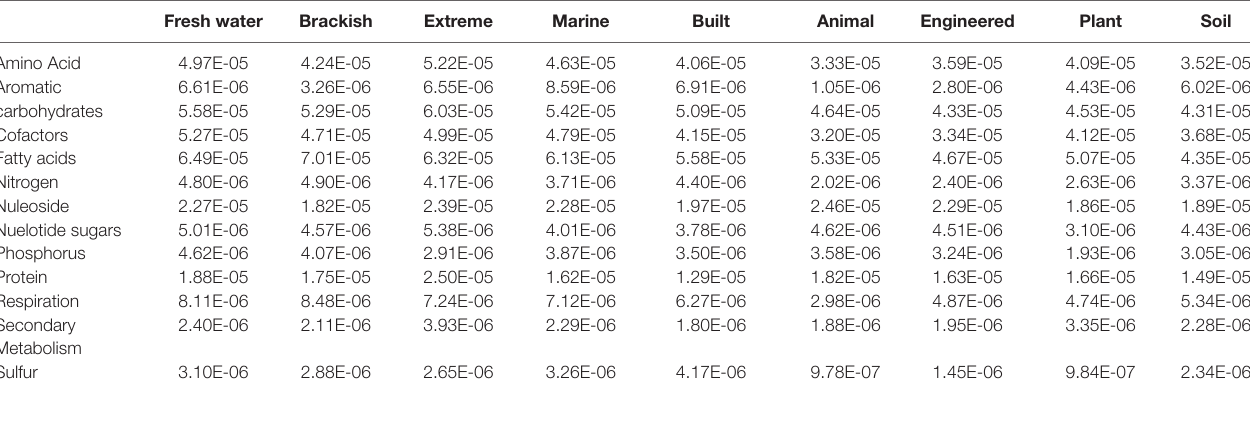
TABLE 1 | Number of studies and metagenomes within each ecosystem.